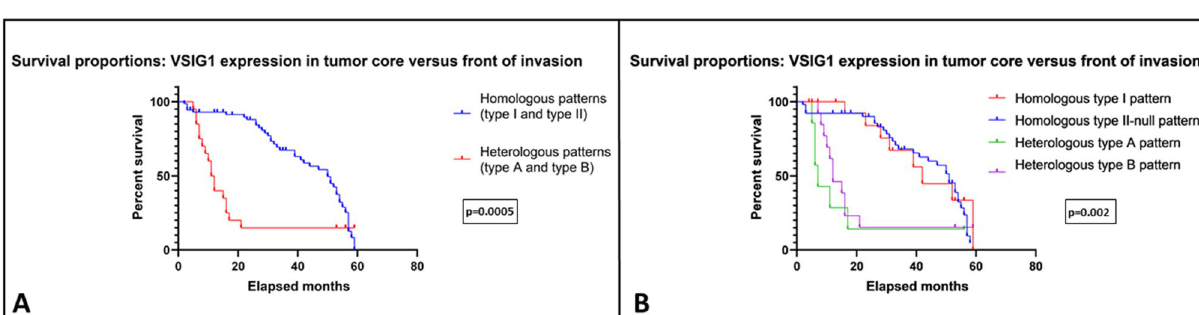
Figure 5. Overall survival rate (OS) is influenced by the subcellular localization of VSIG1. Homologous patterns associate a better OS, compared with the heterologous tumors ( A ). No differences occur between heterologous type A vs. B either between homologous type 1 vs. 2 ( B